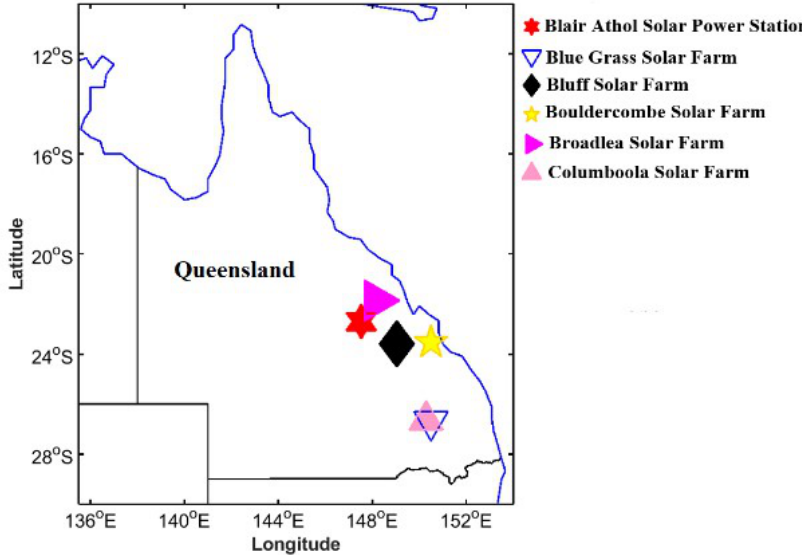
Figure 3. The present study area showing six solar energy farms in Queensland Australia where the deep learning hybrid stacked LSTM sequence-to-sequence autoencoder (i.e., SAELSTM) model was developed to predict daily